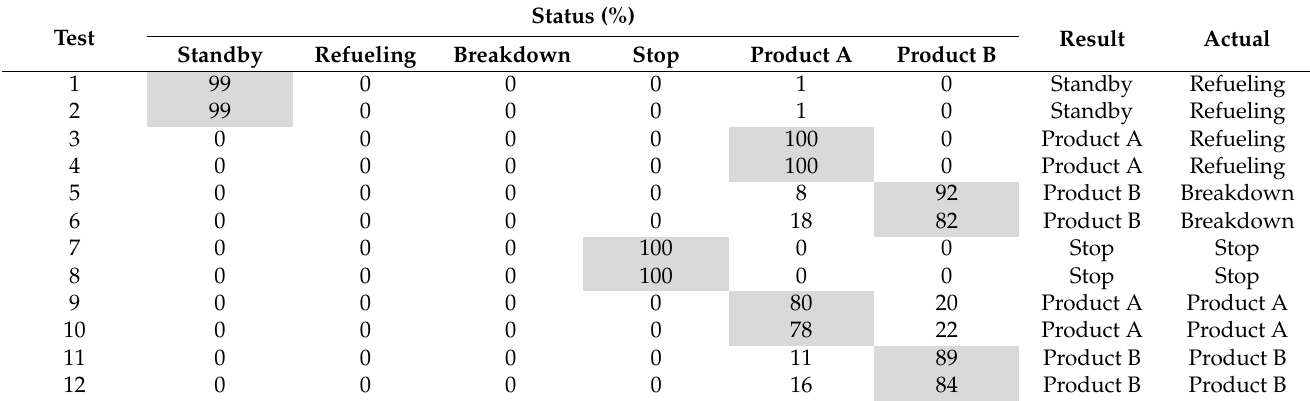
Table 2. Processing status analysis of the multi-method framework.